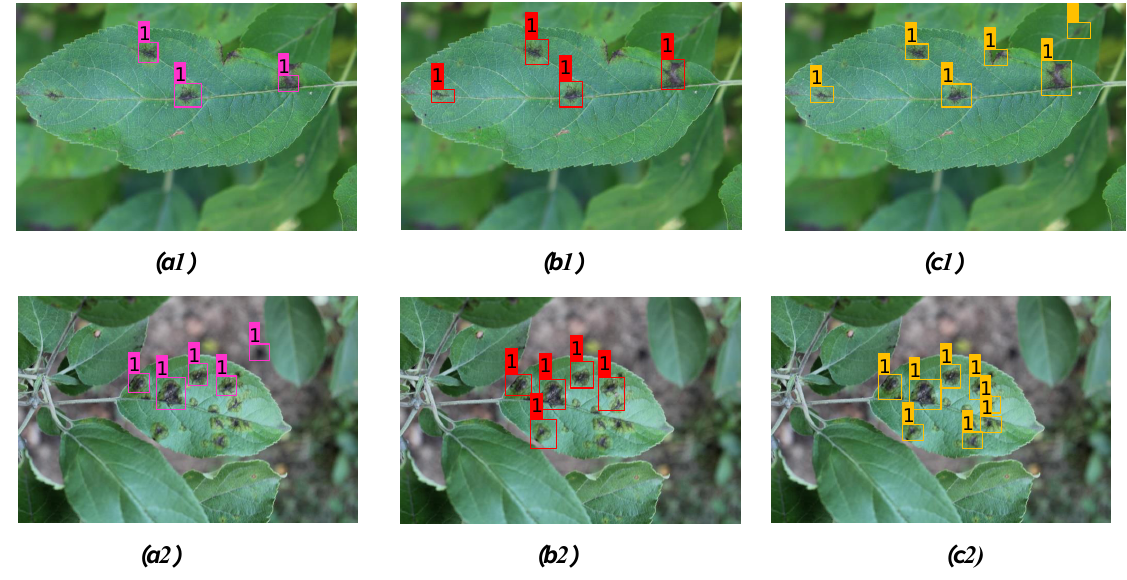
Figure 8. Comparison of detection result for apple scab on two distinct apple leaves from three models: ( a1 , a2 ) YOLOv3; ( b1 , b2 ) YOLOv4; ( c1 , c2 ) proposed model. Table 6. Comparison of detection results between YOLOv3, YOLOv4, and the proposed model for apple scab detection as shown in Figure 8. Bold highlights the best result obtained from corresponding model prediction. Figs. No